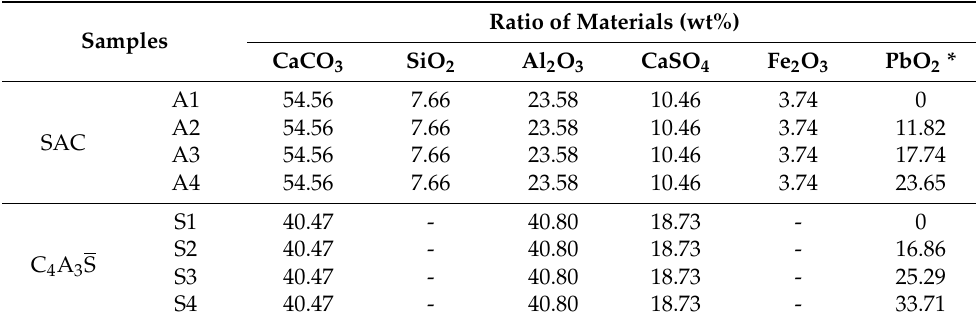
Table 1. The ratios of materials used to prepare pristine and Pb-doped SAC clinker and the min- eral C 4 A 3